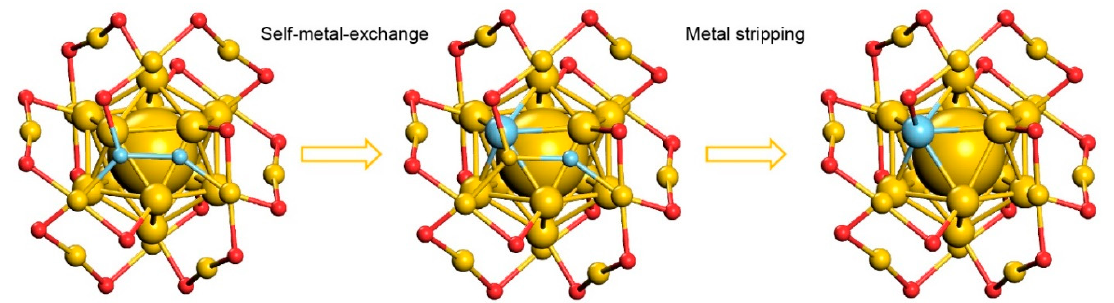
Figure S1: The full spectra of Ag 2 Au 25 nanocluster with different laser energy during the MALDI-TOF-MS analysis. The intensity of Au 2 Au 25 ; Figure S2: Time-dependent MALDI-TOF-MS spectra of metal exchange between Au 25 (SR) 18 Ag(SR) (4 equivalents) complex. (a) 0 min; (b) 5 min; and (c) 15